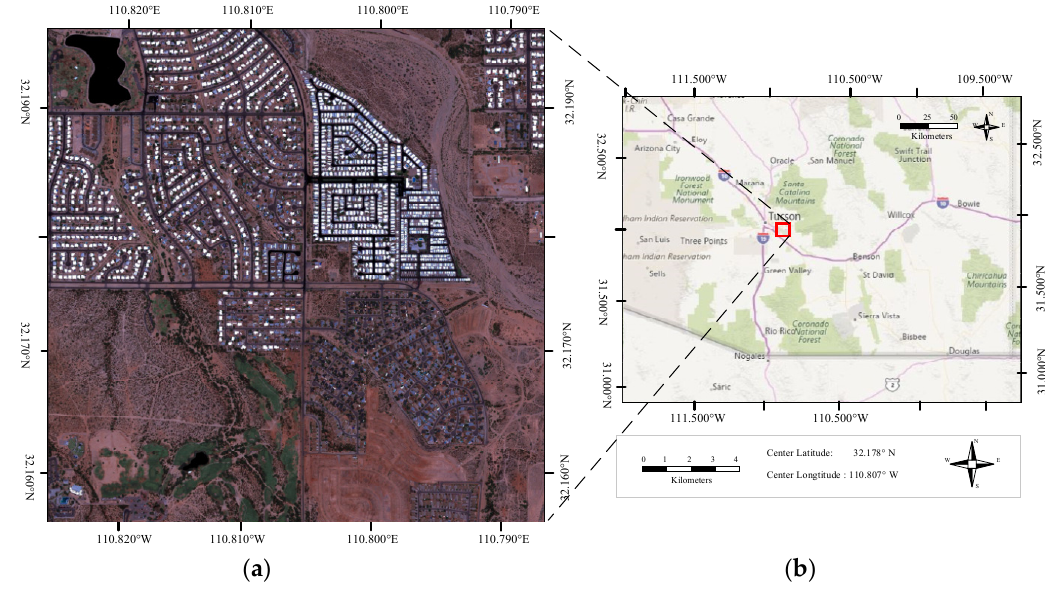
Figure 9. ( a ) The original image of Scene-TA; ( b ) The geographic location of Scene-TA.